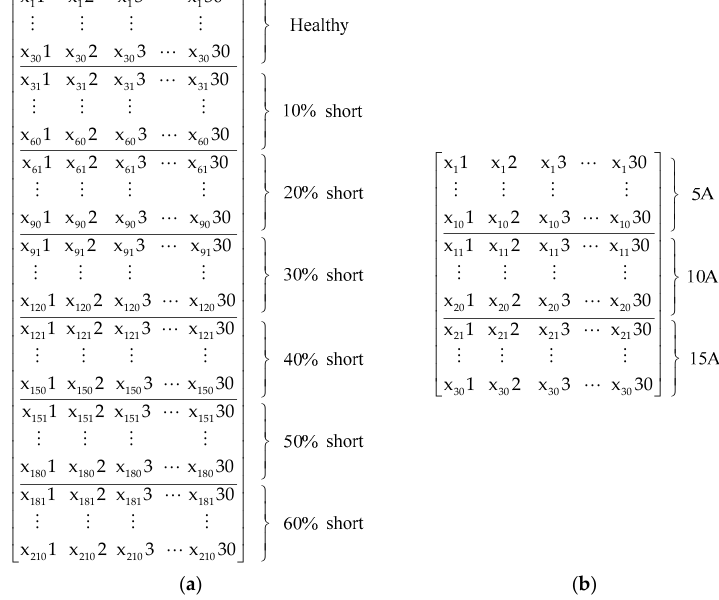
Figure 4. The structure of training matrix ( a ) full training matrix for different degree faults; and ( b ) training matrix for healthy case.